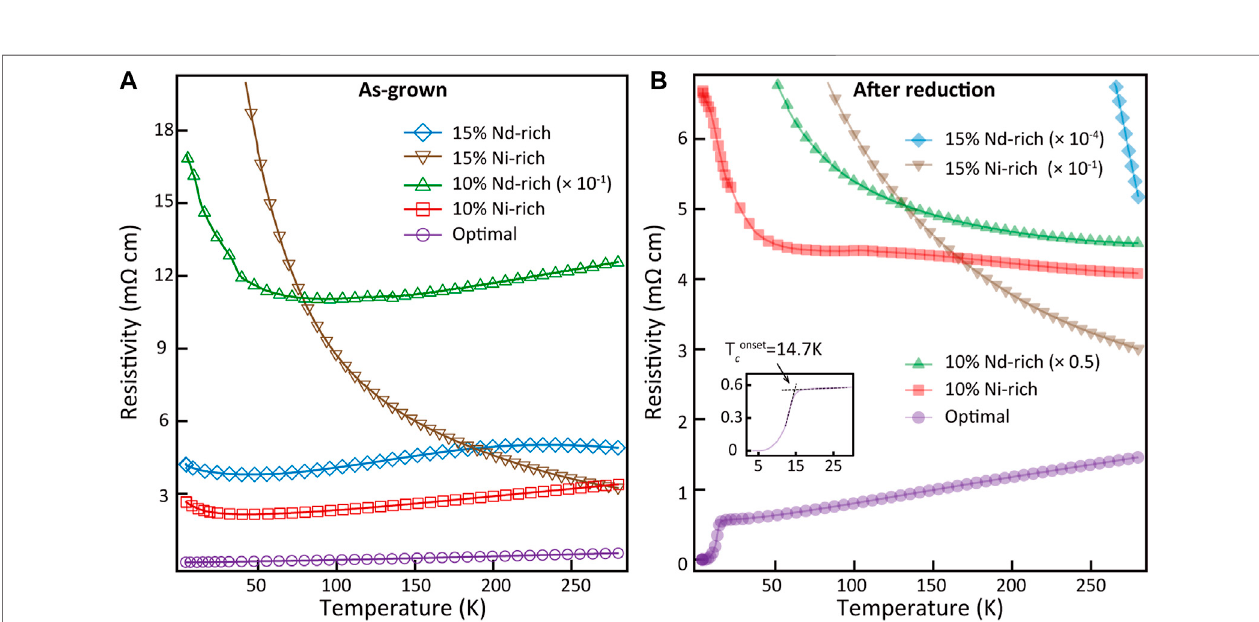
FIGURE 4 | Effect of cation stoichiometry on the transport properties of Nd 1- x Sr x NiO 3 and Nd 1- x Sr x NiO 2 . Temperature-dependent resistivity for reduced nickelate fi lmsgrownunderoptimalandoff-stoichiometric fl uxratiosbefore (A) andafter (B) reduction.Theresistivitiesofseveralsampleswerescaledforclarity,asdenotedinthe legends. InsetofBshowsthezoom-in viewatlowtemperaturesfrom 3to30 Kofoptimal Nd 0.8 Sr 0.2 NiO 2 sample.Theonsettransitiontemperature isabout 14.7 K,and zero resistivity is achieved at about 4.7 K.